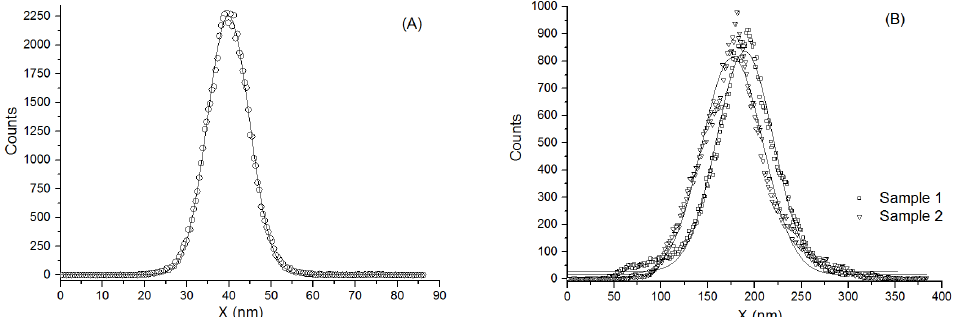
Figure 3. Height histograms of AFM images presented in Figure 2 of: Sample 0 ( A ), sample 1 and sample 2 ( B ).